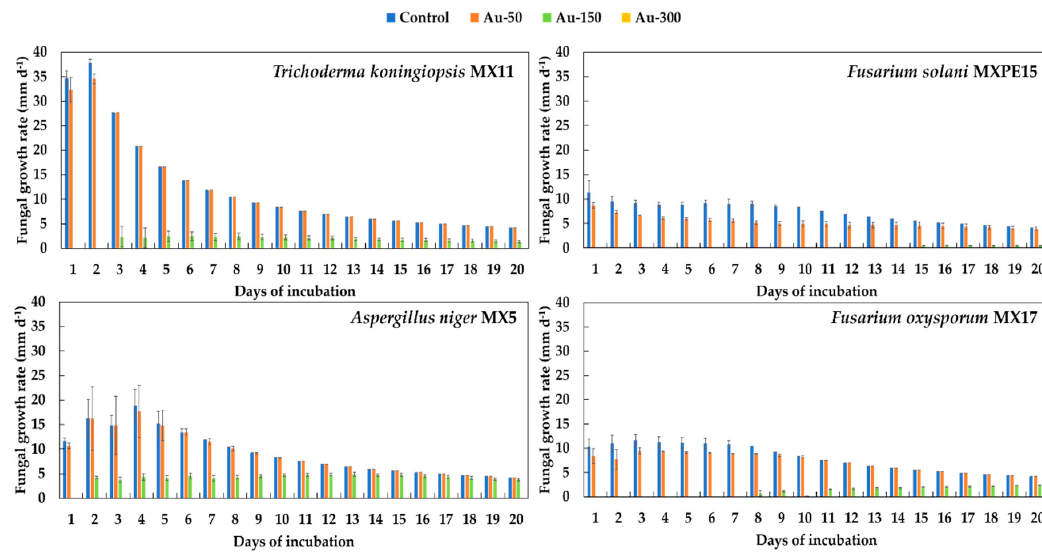
− 1 ). Appl. Sci. 2020 , 10 , x FOR PEER REVIEW